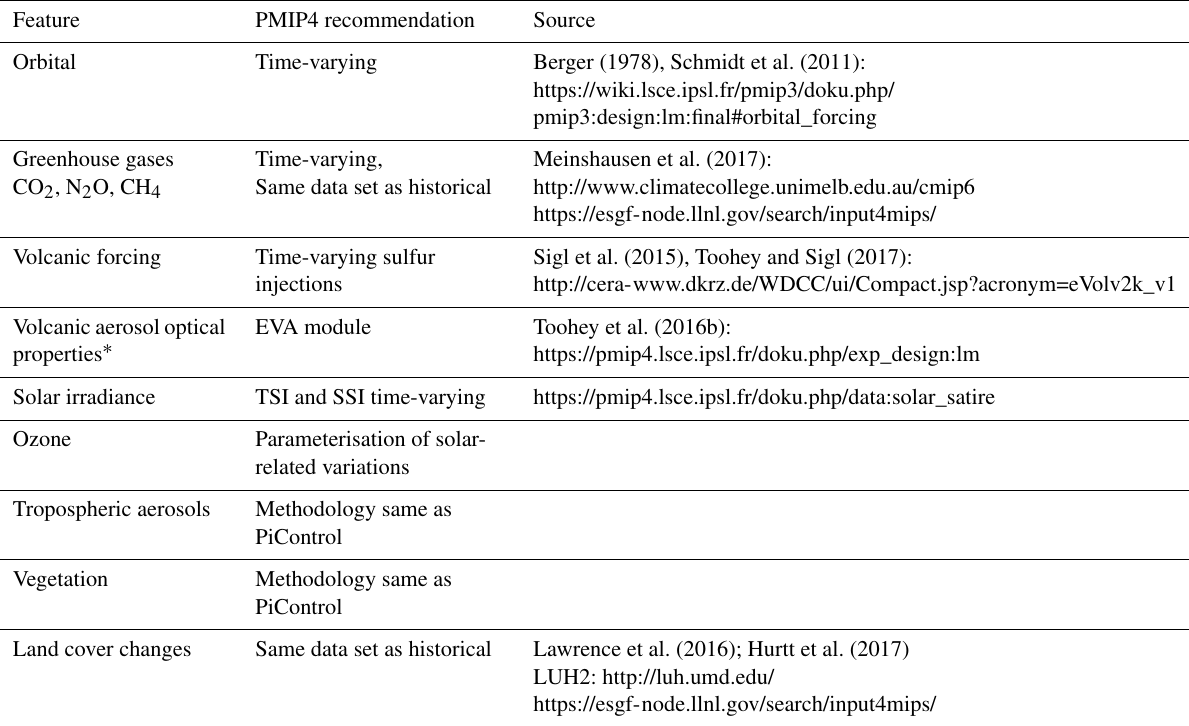
Table 2. Summary of boundary conditions for the PMIP4-CMIP6 Tier 1 past1000 experiment.